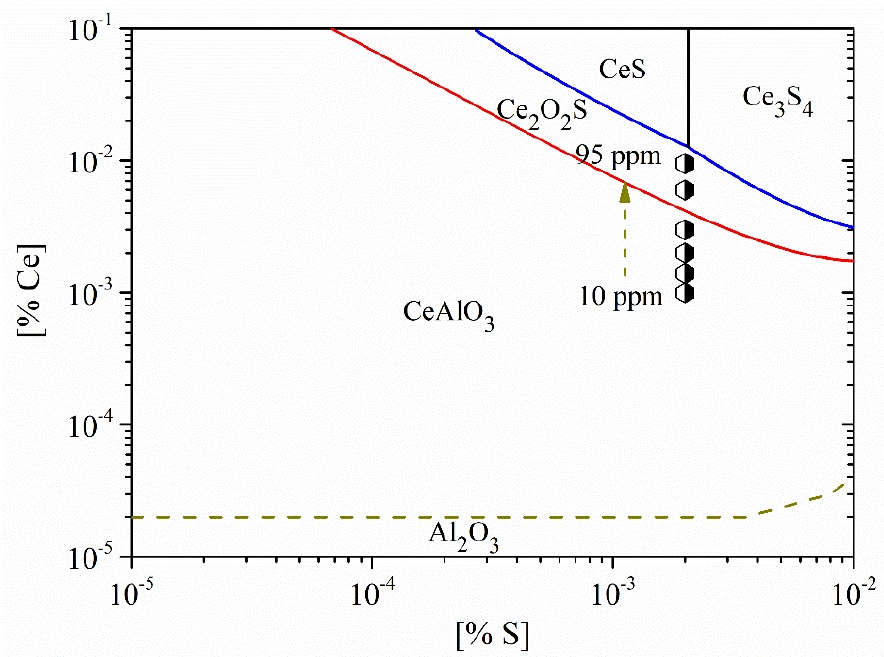
Figure 14. Stability diagram of Al 2 O 3 -CeAlO 3 -Ce 2 O 2 S-Ce x S y in non-oriented electrical steel.